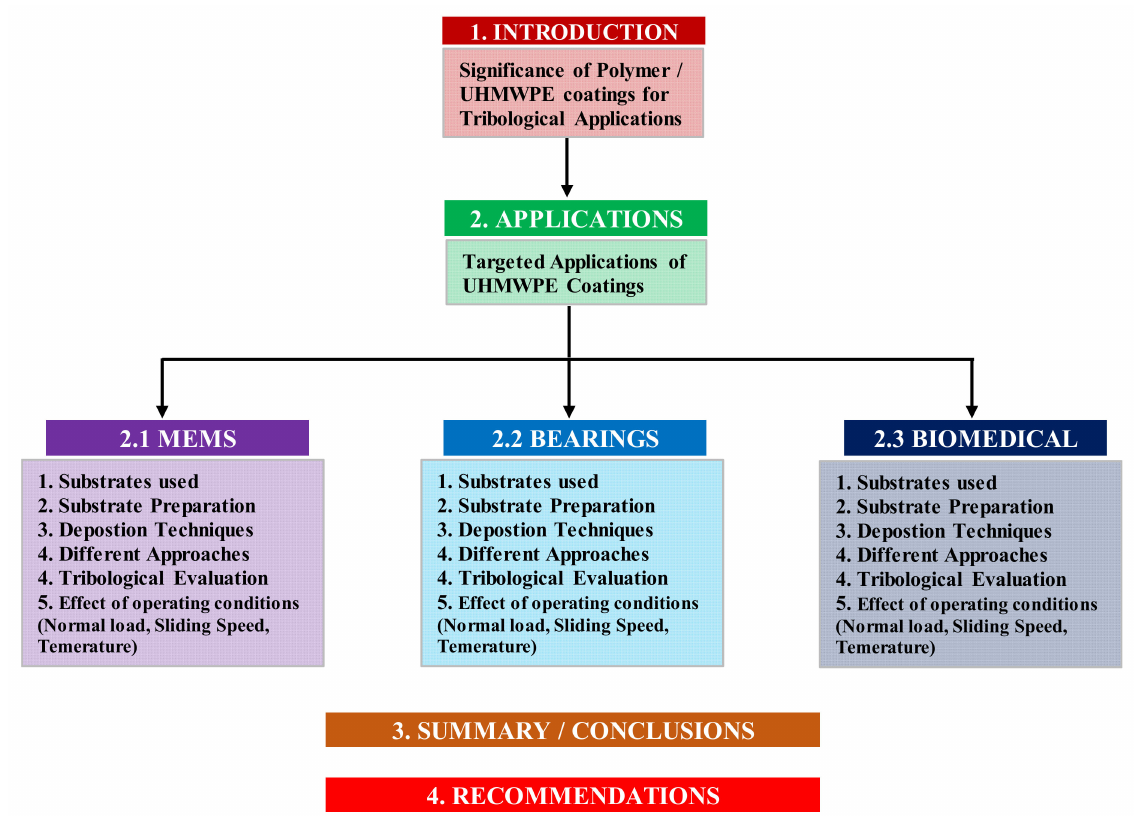
Figure 3. A bird’s view of the arrangement of this